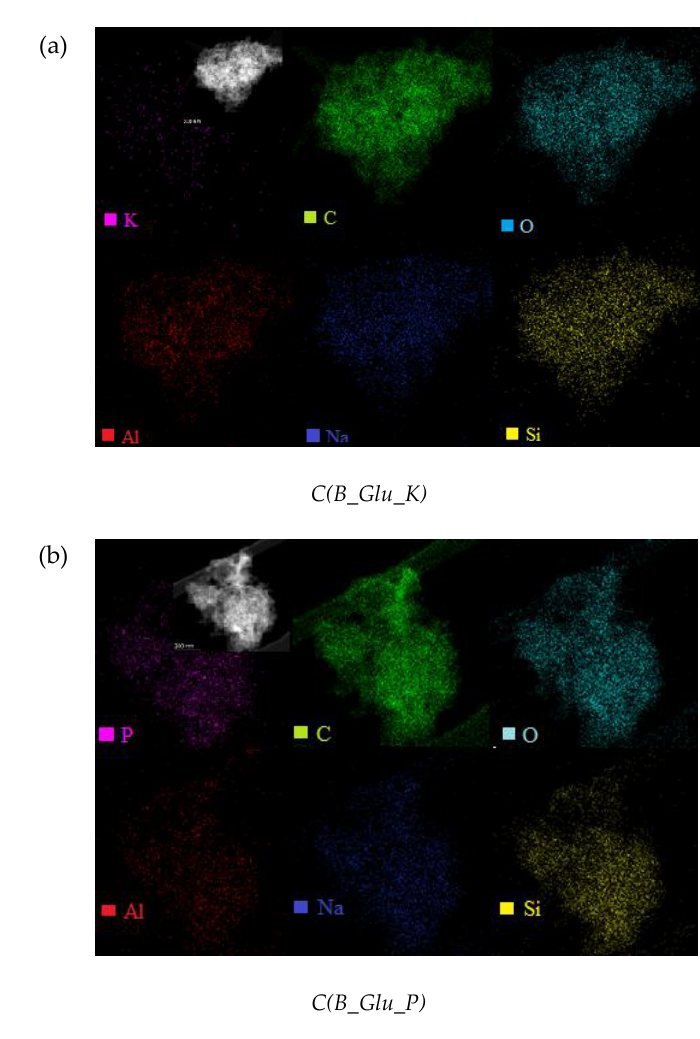
Figure 12. Mappings for ( a ) C(B_Glu_K) and ( b ) C(B_Glu_P).